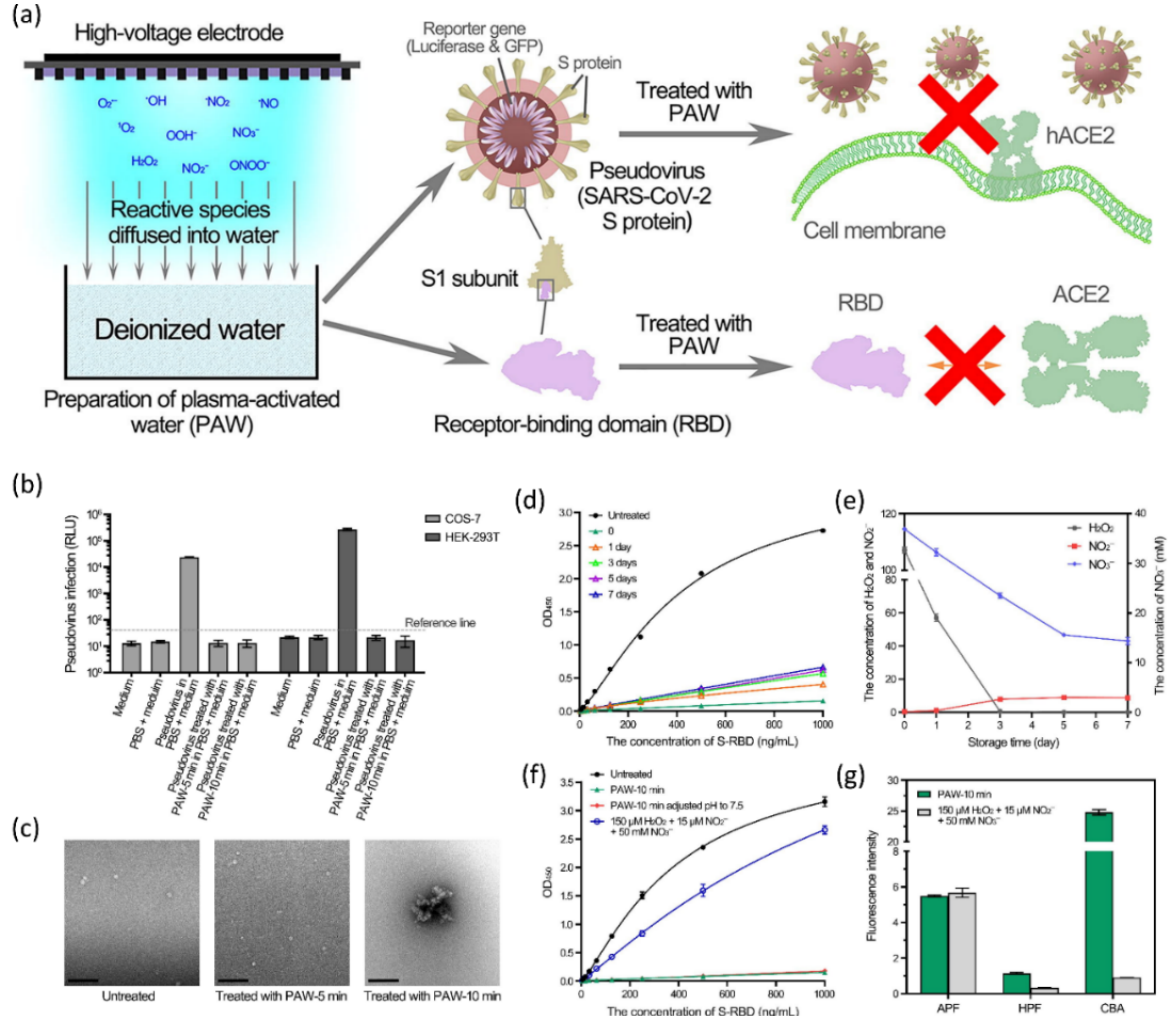
Figure 9. ( a ) A graphical representation of NTAP water treatment to prepare PAW and its applica- tion to COVID-19. ( b ) PAW inactivation of pseudovirus. Infection of COS-7 and HEK-293T cells with control and PAW-treated pseudovirus. ( c ) TEM analysis of PAW-treated pseudoviruses. The pseudoviruses treated with PAW-5 min and PAW-10 min, as well as the untreated pseudovirus, were negative stained and TEM examined. ( d ) The effects of PAW inactivation after storage. ( e ) Storage of long-lived species. The concentrations of H 2 O 2 and NO 2 /NO 3 in PAW-10 min stored for the indicated times were measured. ( f ) A comparison of the inactivation effects of PAW and a mixture of H 2 O 2 , NO 2 , and NO 3 . ( g ) Short-lived species in PAW and the H 2 O 2 , NO 2 , and NO 3 mixed solution. Reused with permission from [147]. Copyright 2021, Elsevier.